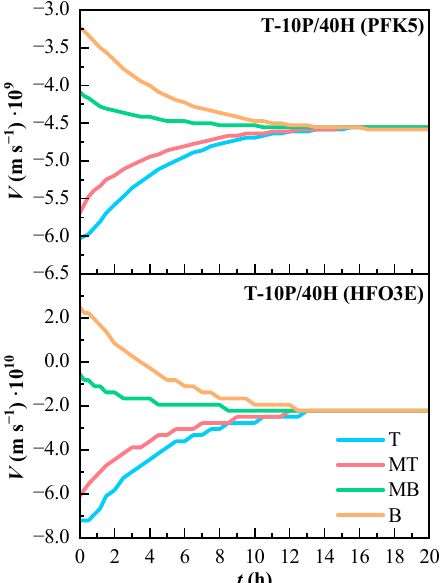
Figure 7. Variation of the estimated convection velocity ( V ) of the components of the ternary mixture over time. T (Top), MT (Medium Top), MB (Medium Bottom), and B (Bottom) correspond to the different heights of the measurement